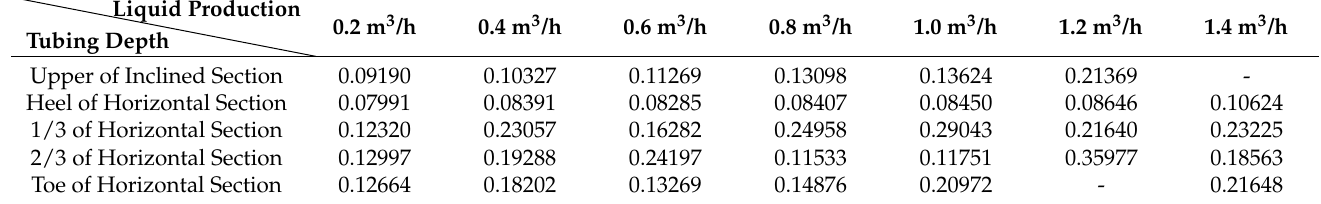
Table 3. Standard deviation between liquid flow rate and production in different tubing depths.